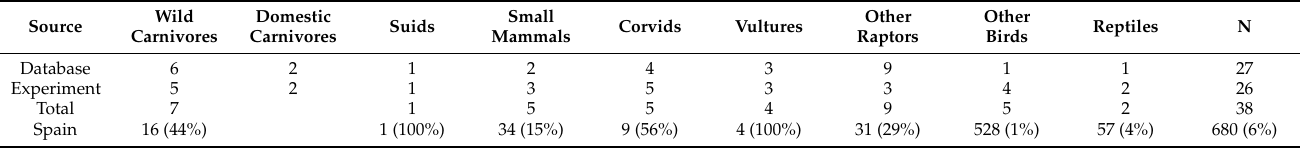
Table 2. Number of species recorded as poisoned in the “Ant í doto Programme” database and observed feeding on baits during the field experiment in the six study areas per species group. The total shows the number of species that occurred in both the database and the experiment. We also show the number of species of each group that are present in peninsular Spain, along with the percentage of species that represents those involved in this